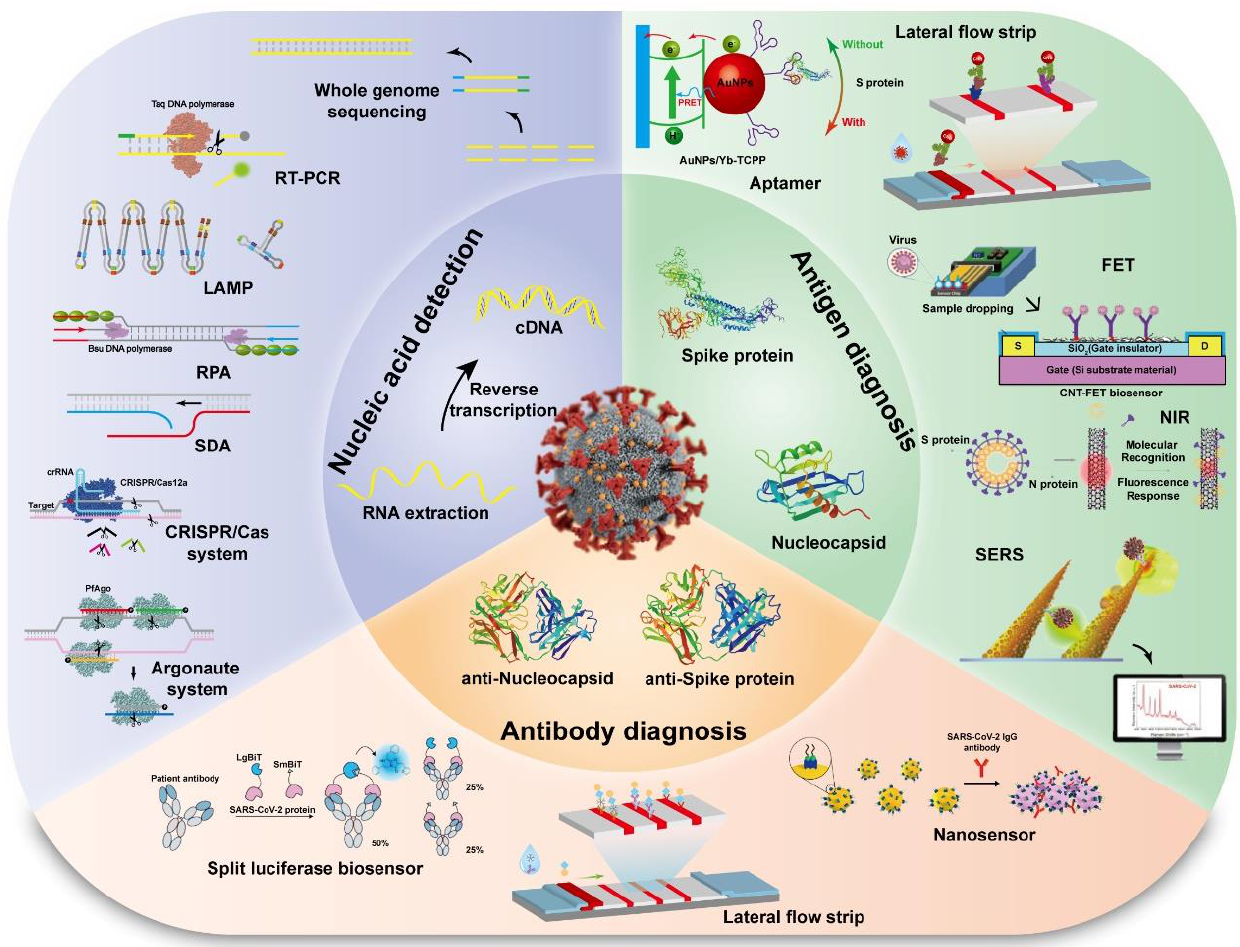
Figure 3. The detection methods for SARS-CoV-2 based on the biological-recognition elements.